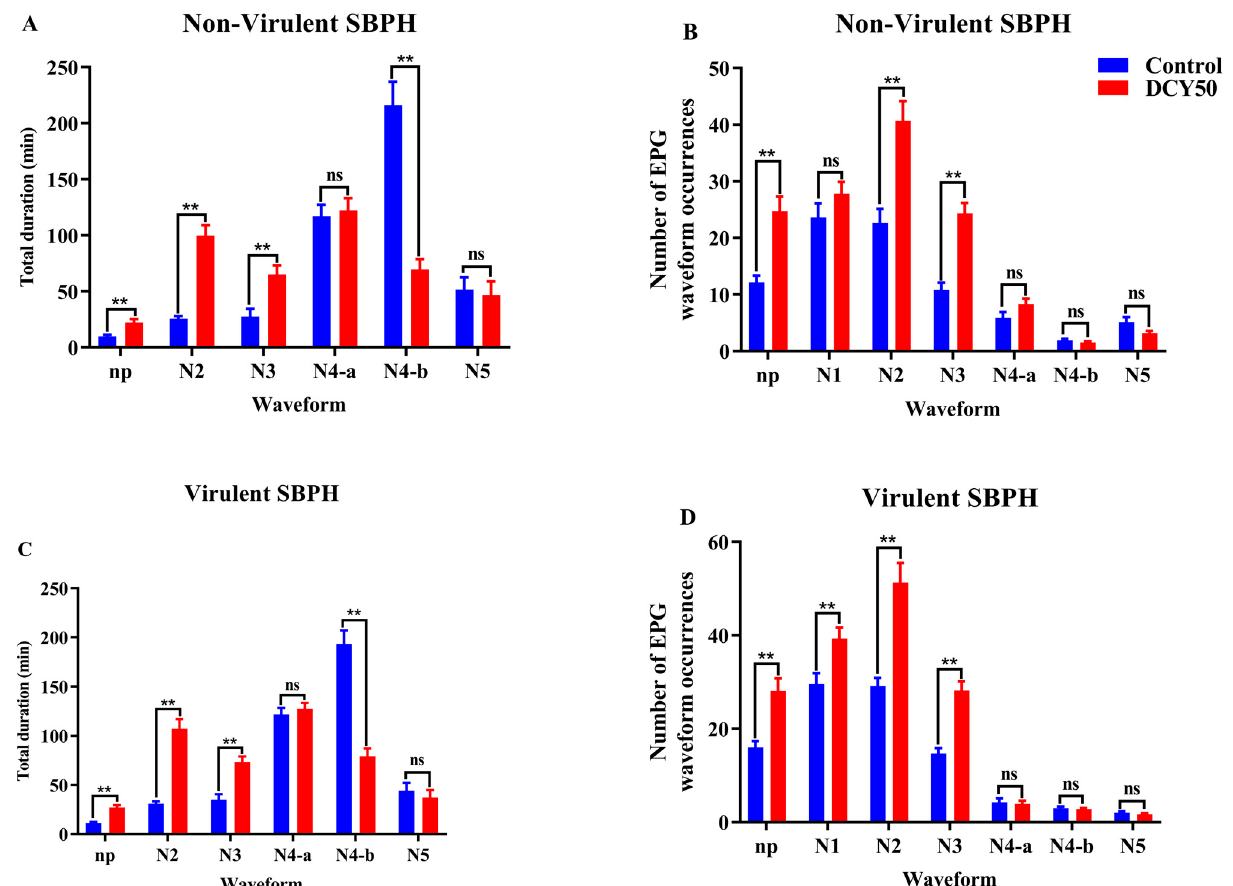
Figure 5. EPG waveform frequency and duration of SBPH feeding on rice. Different EPG waveform durations ( A ) and occurrences ( B ) recorded from non-virulent SBPH feeding on control and DCY50- treated rice plants. Different EPG waveform durations ( C ) and occurrences ( D ) recorded from virulent SBPH feeding on control and DCY50-treated rice plants. Asterisks (**) indicate significant (ns = non-significant) differences between treatments and controls ( p < 0.05, Tukey’s HSD test). The data were expressed as the mean ±